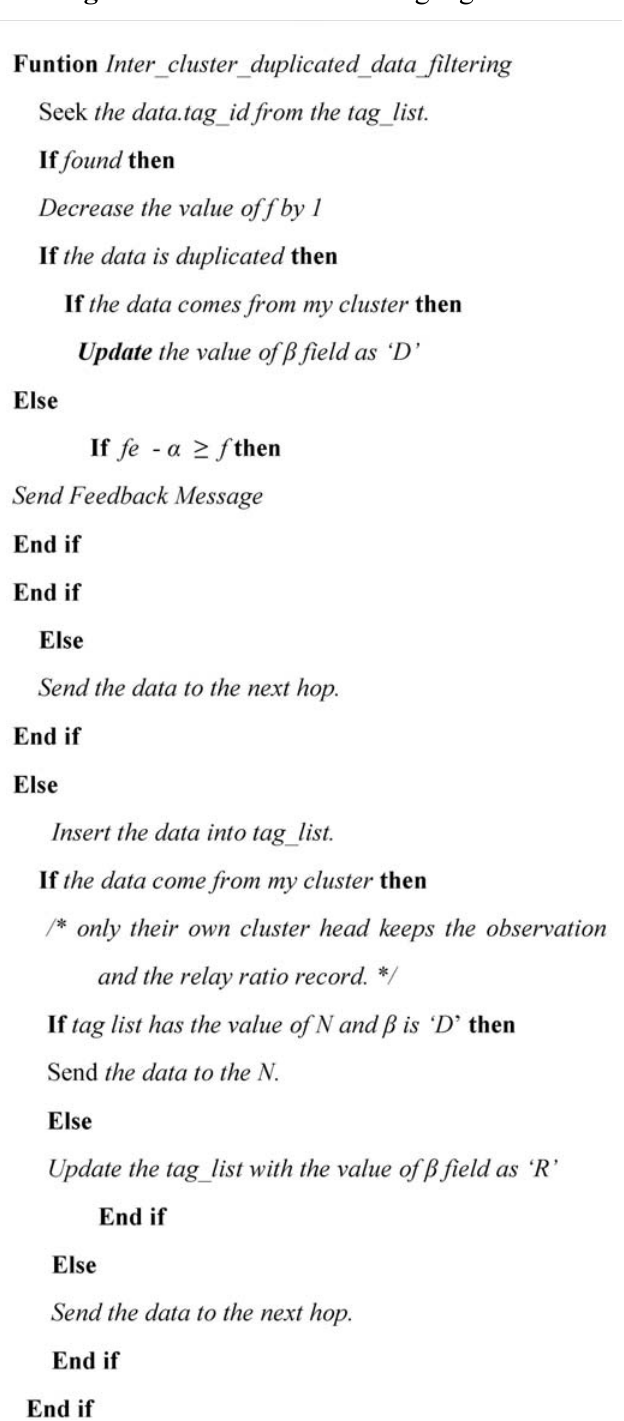
Figure 7. Inter-cluster filtering